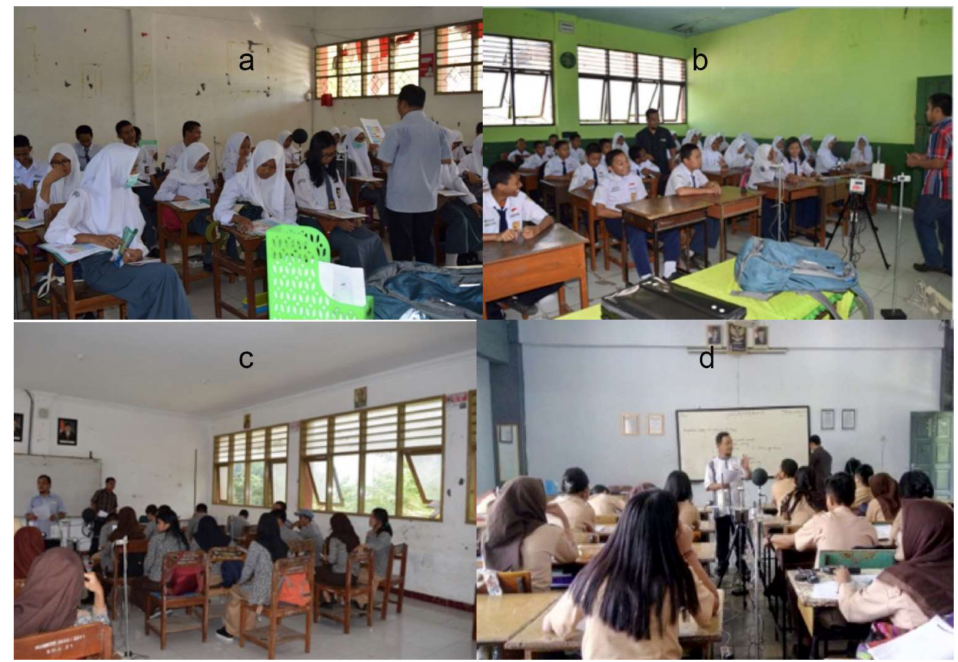
Figure 2. The situation of survey and measurement in the classrooms. Students clothing for each photo: ( a ) Regular uniform for SMAN; ( b ) Regular uniform for SMPN; ( c ) Batik uniform; and ( d ) Pramuka